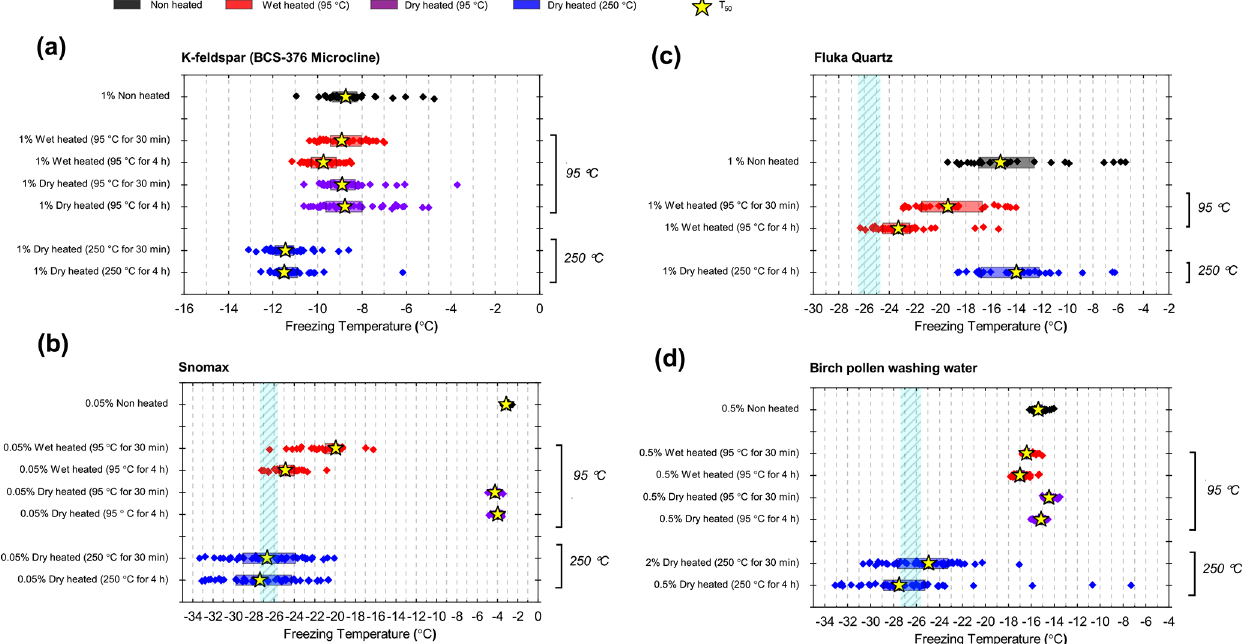
Figure B2. Boxplots of freezing temperatures for droplet freezing assays of suspensions of (a) BCS-376 microcline (1% w/v ), (b) Fluka quartz (1% w/v ), (c) Snomax ® (0.05% w/v ) and (d) birch pollen washing water (0.5% w/v ) before and after wet heating and dry heating at varying temperatures and